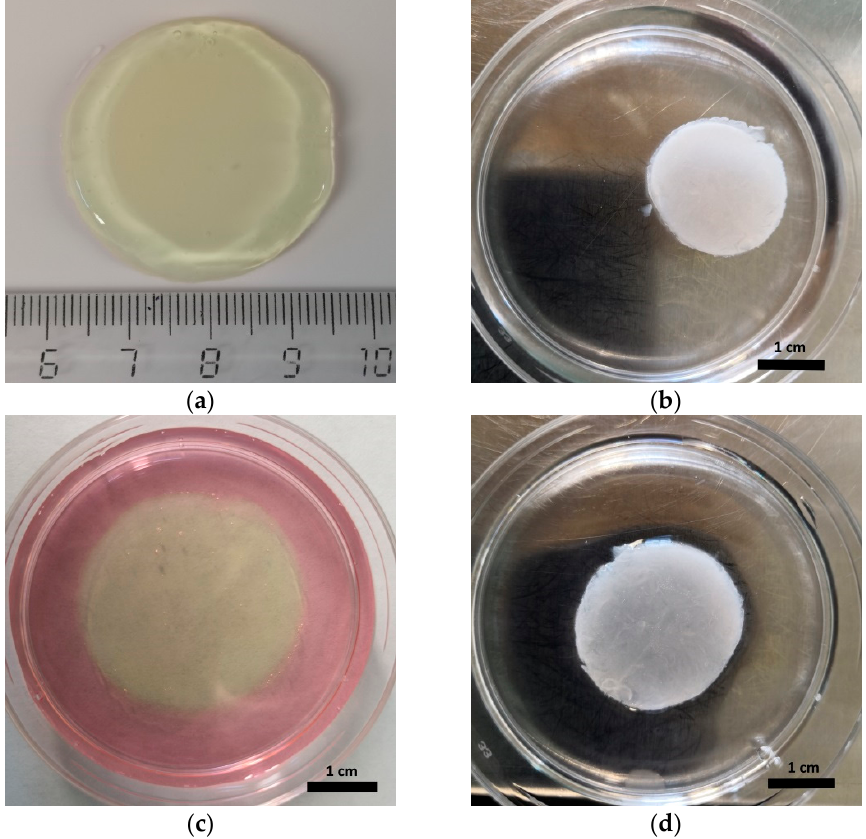
Figure 3. Representative photographs of scaffolds before and after cryopreservation: ( a ) typical appearance of scaffold before cryopreservation; ( b ) appearance of a scaffold after 3 months of cryopreservation and 24 h of culturing (scaffolds look identical after 3, 6, 9 and 12 months of cryopreservation and 24 h of culturing); ( c ) appearance of scaffolds after 3 months of cryostorage followed by 96 h cultivation; ( d ) appearance of scaffolds after twelve months of cryostorage followed by 96 h cultivation.